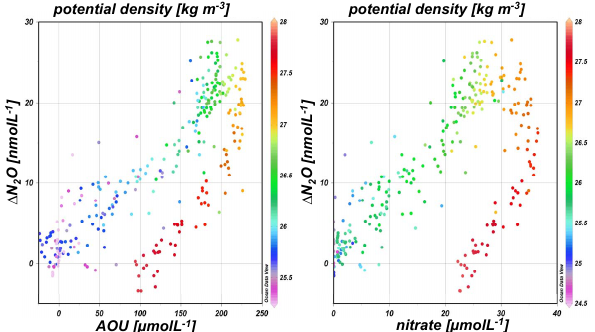
Fig. 2 Fig. 2. 1 N 2 O versus the apparent oxygen utilization (AOU) and nitrate in the ETNA (data from cruises ATA03, P348 and P399), the potential density is colour-coded.